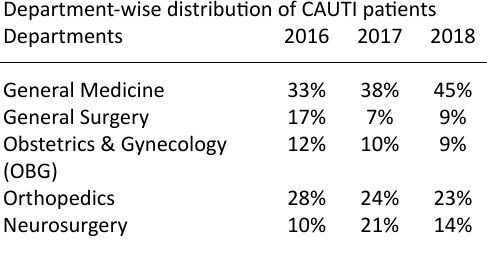
Table 2. Department-wise distribution of patients with CA-UTI